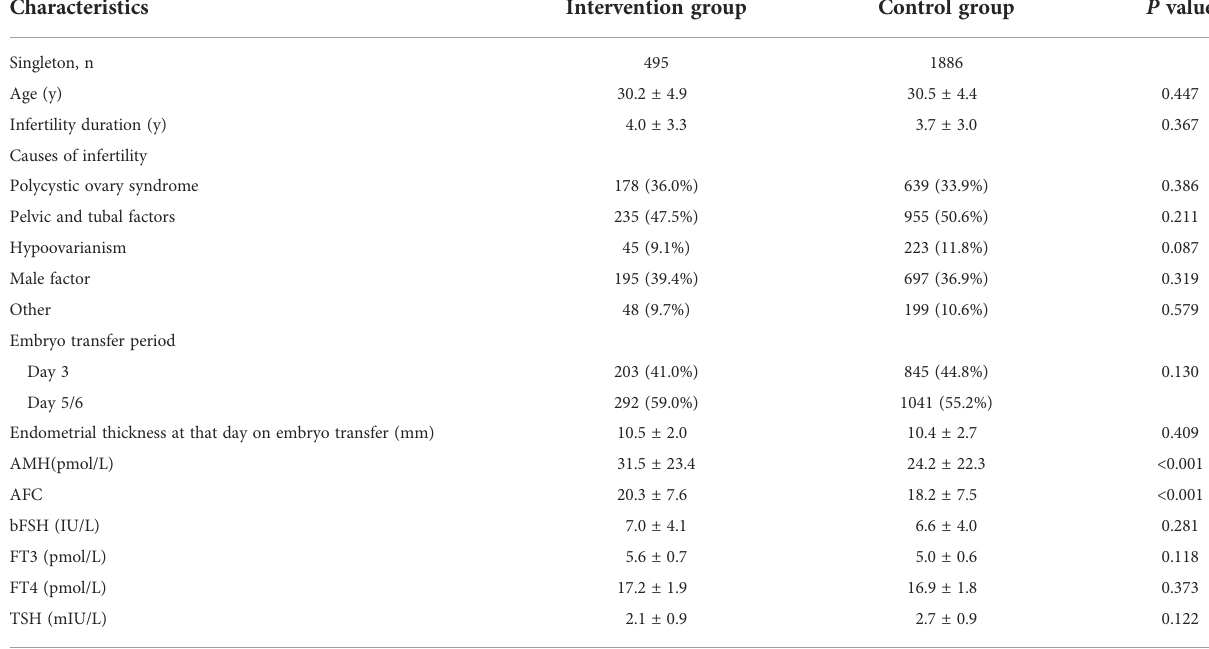
TABLE 1 Characteristics of the intervention group and the control group.